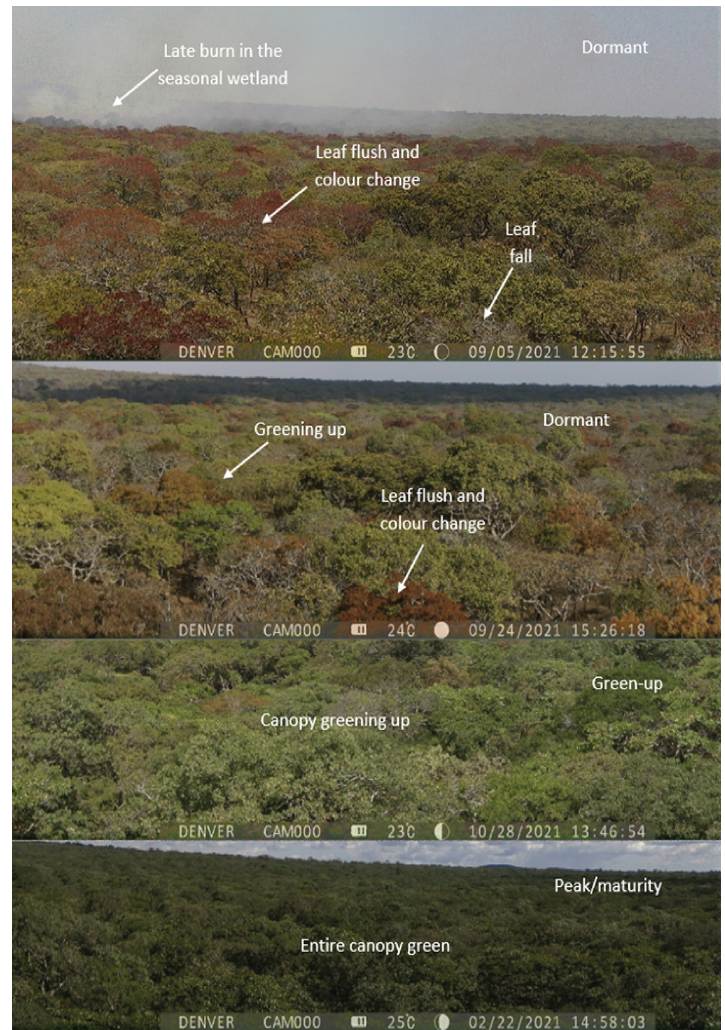
Figure A3. Photographs of the top of the woodland canopy at Mpika site showing changes in canopy leaf cover in the dormant and green-up